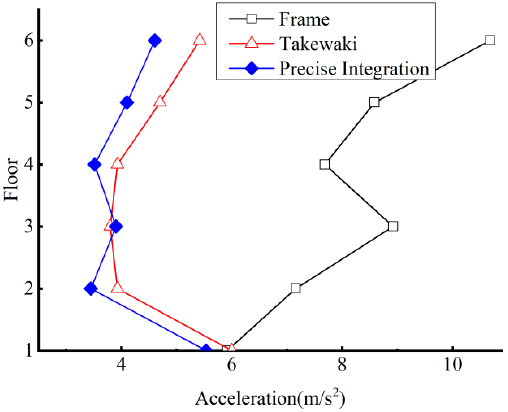
Figure 8. Six-story shear frame: Accelerations by different response calculation methods [25].